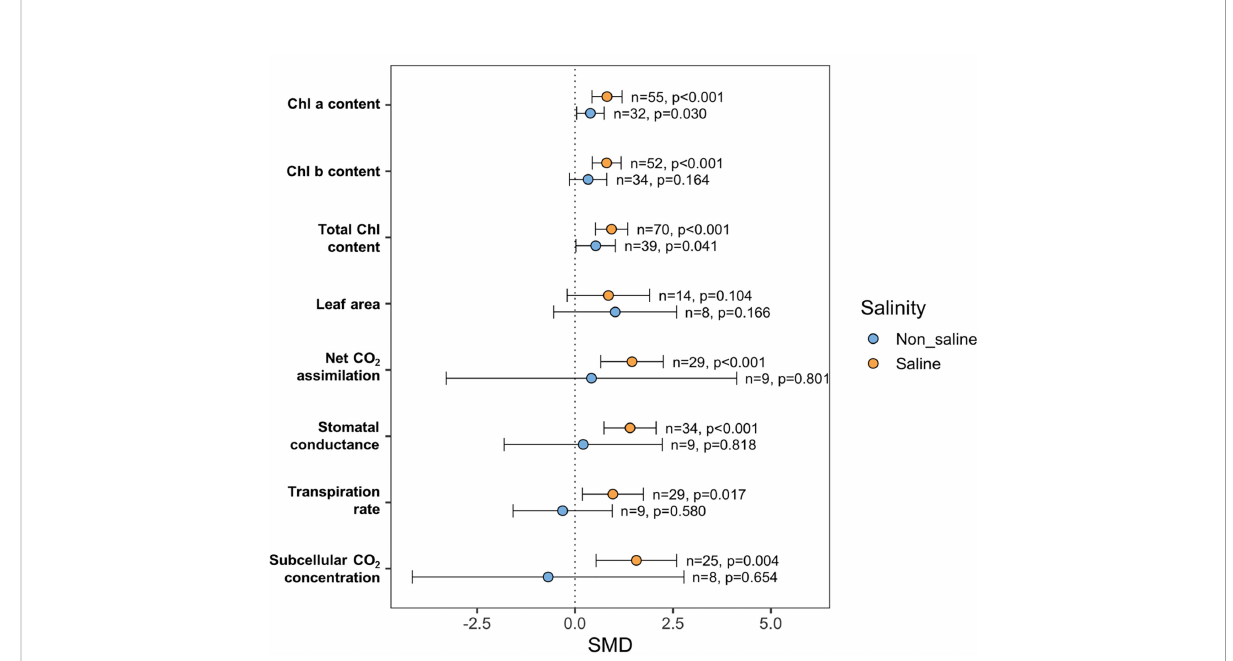
FIGURE 6 Effects of exogenous NO on photosynthesis-related parameters such as chlorophyll-a (Chla), chlorophyll b (Chlb), total chlorophyll (total Chl) content, leaf area (LA), net CO 2 assimilation (Pn), stomatal conductance (Gs), transpiration (E) and sub-cellular CO 2 concentration (Ci) under saline and non-saline conditions. The error bars are the effect size means ±95% CIs. Where the CIs do not overlap the vertical dashed lines, the effect size for a parameter is signi fi cant, i.e., the growth responses of NO-treated plants were signi fi cantly different from those of non-NO- treated plants. n , the number of studies included in the meta-analysis; p , the signi fi cance level of